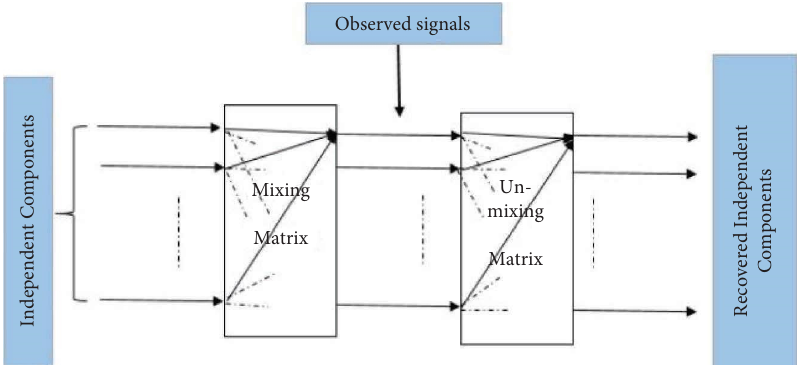
Figure 6: Overview of the ICA problem. Te independent components s and the mixing matrix A both are unknown. Te goal is to estimate A and s from the known x .